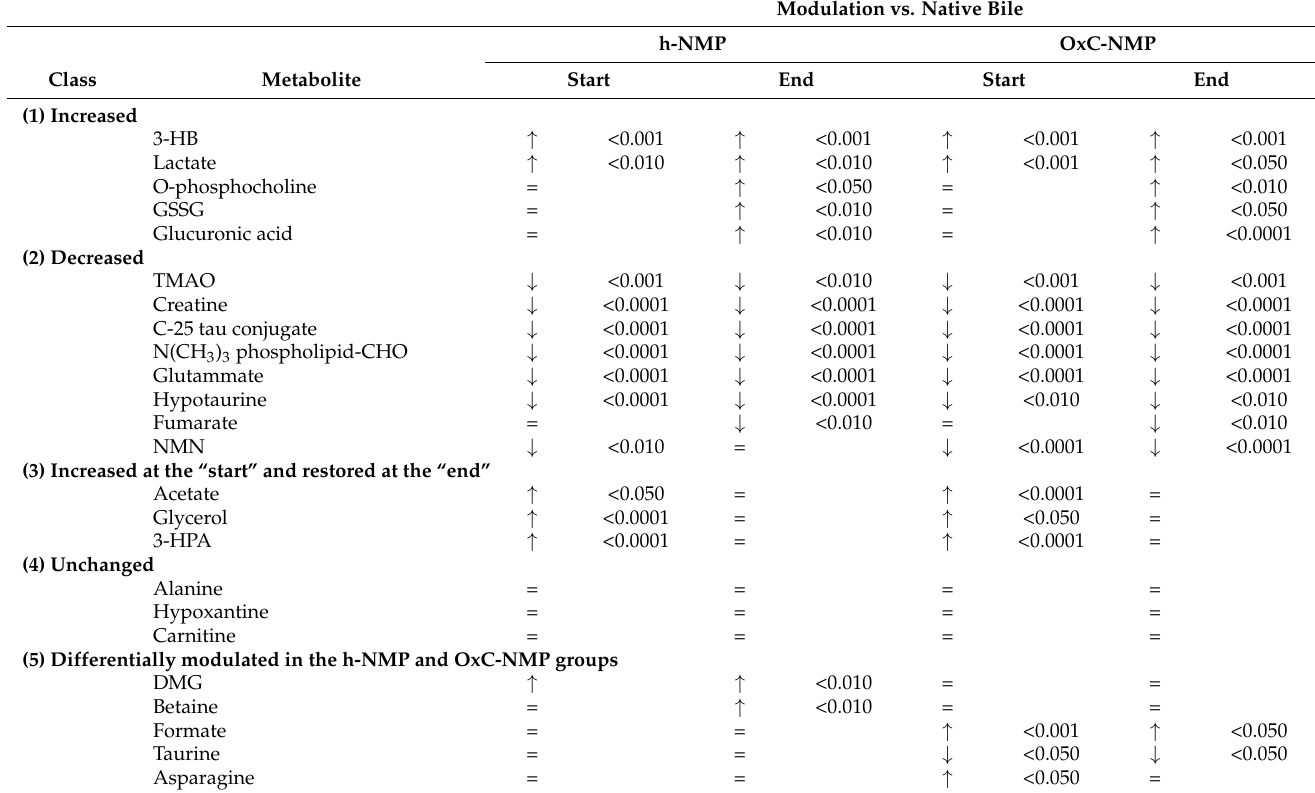
Table 1. Differentially expressed metabolites in bile samples. Metabolites were grouped in one of the following classes: (1) increased compared to Native bile; (2) decreased compared to Native bile; (3) increased at the “start” and restored at the “end” of the NMP procedure; (4) unchanged relative to Native bile; (5) differentially modulated in the h-NMP and OxC-NMP groups. Abbreviations: 3-HB, 3-hydroxybutyrate; 3-HPA, 3-hydroxyphenylacetate; GSSG, glutathione disulfide (oxidized form); NMN, nicotinamide ribotide; TMA, trimethylamine; TMAO, trimethylamine N-oxide. Modulation vs. Native Bile h-NMP